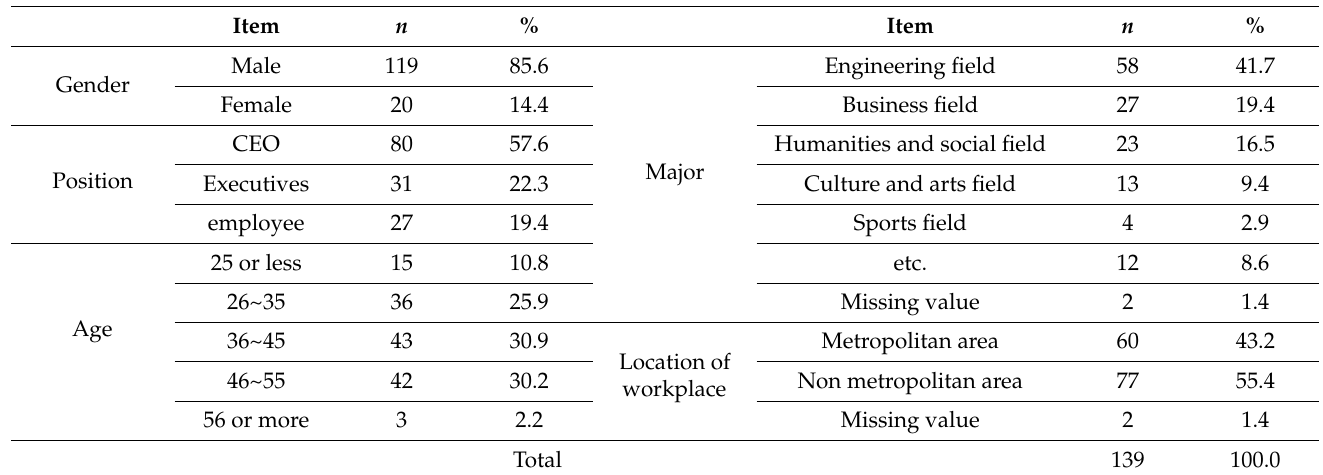
Table 2. Characteristics of